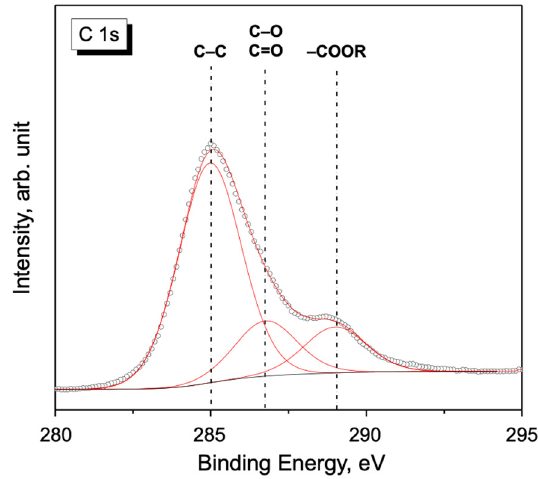
Figure 2. C 1s spectra of PL_UW samples.